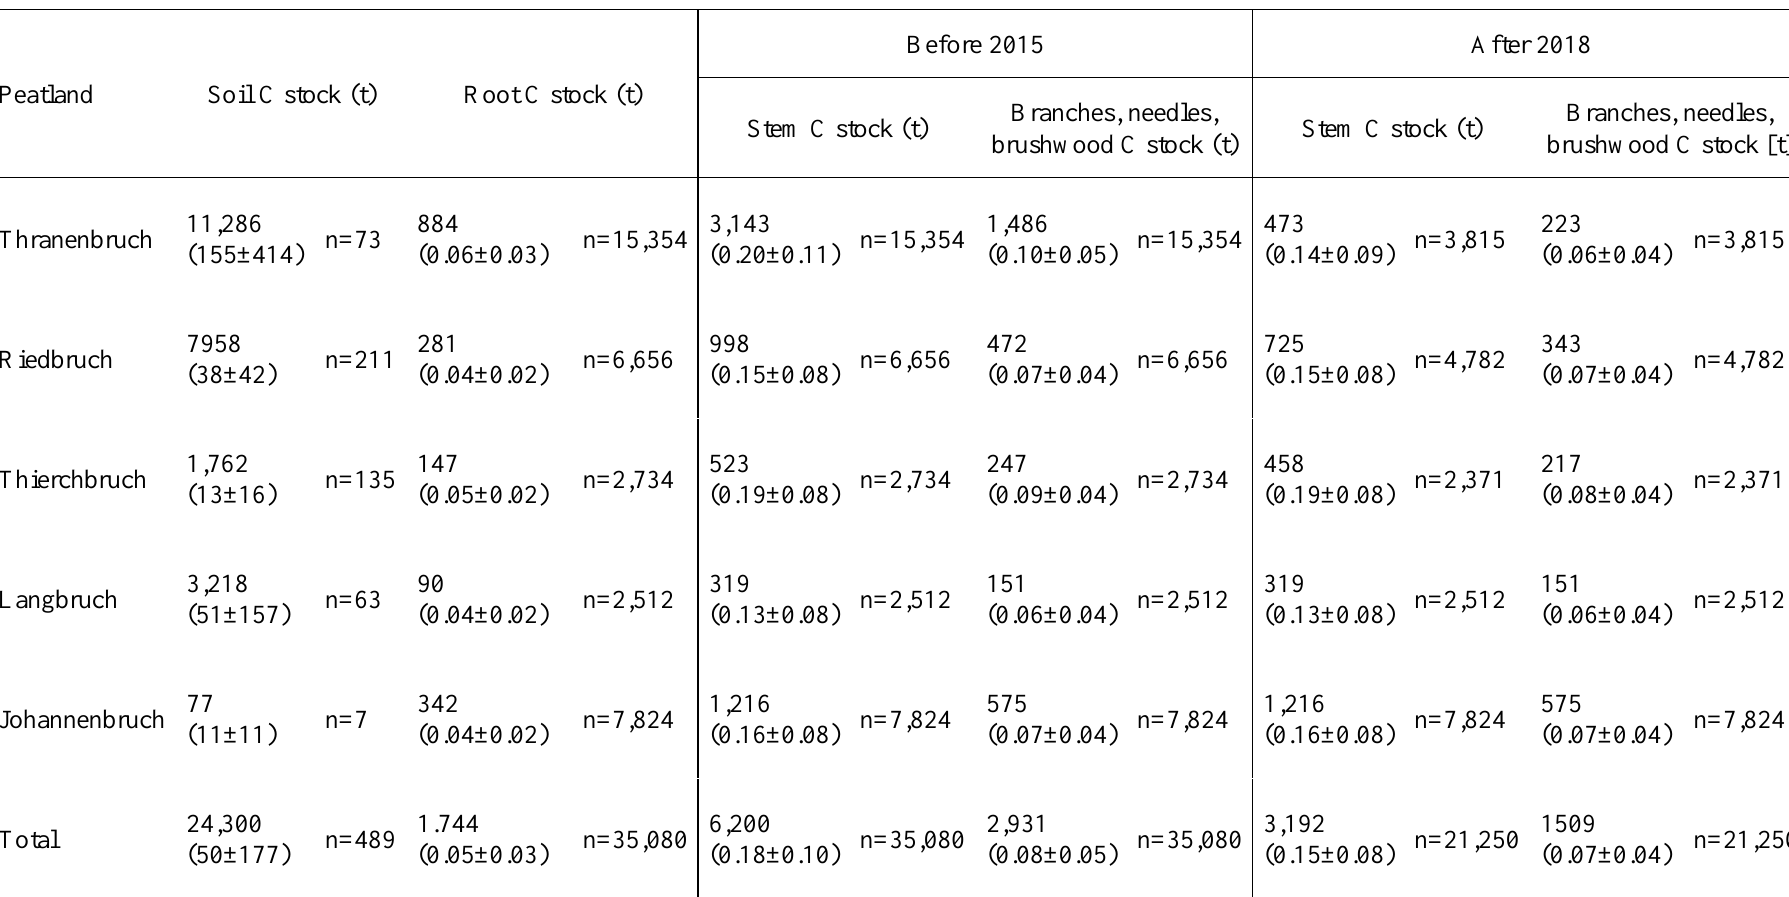
Table 3. Total carbon stocks (mean (± SD) of subtotals) of soils, roots, stems and branches before and after tree removal at the monitoring sites. The soil and root C stock were assumed not to have altered